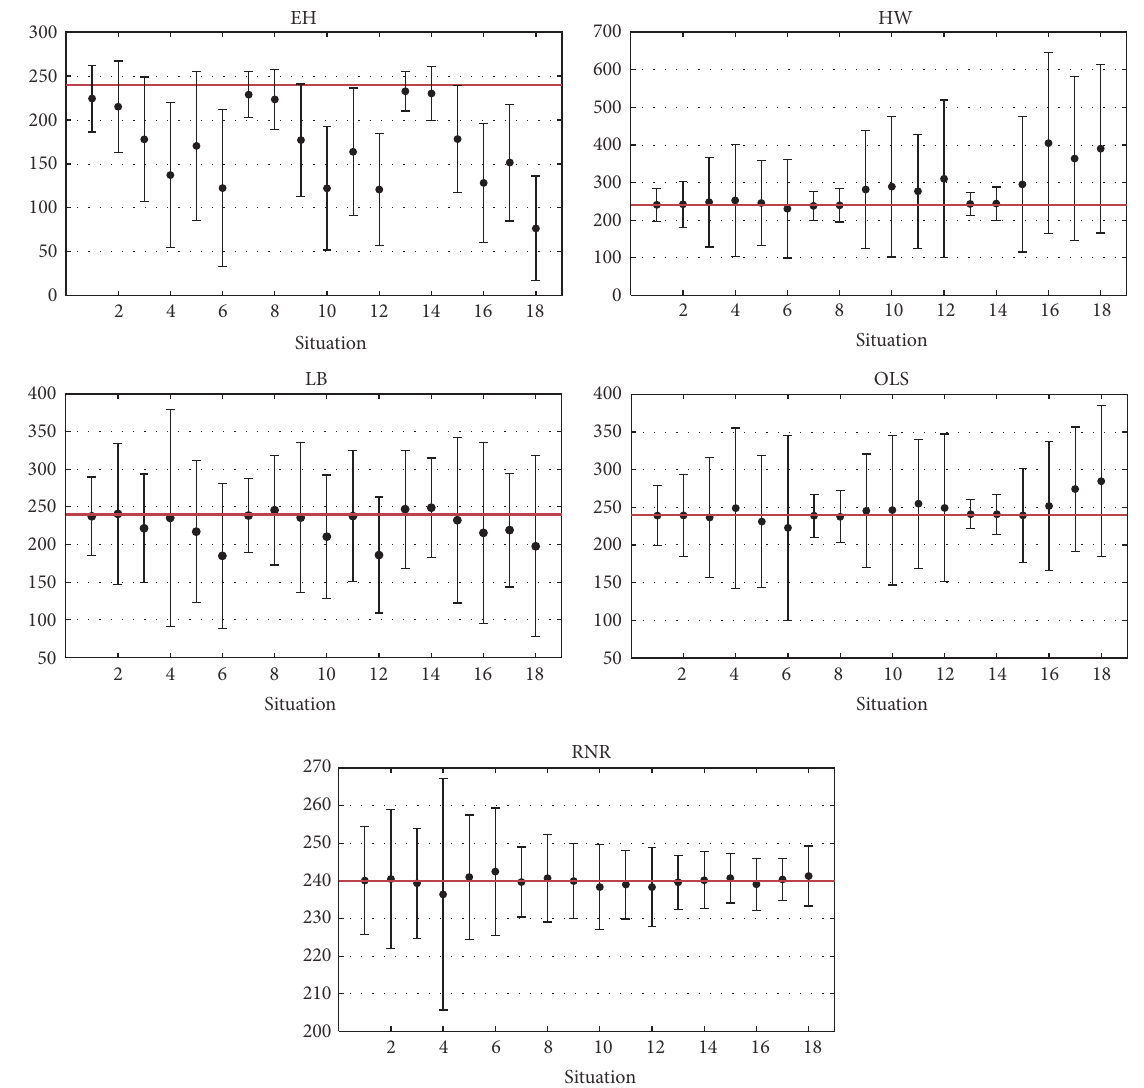
Figure 2: Mean estimated values (black dots) and standard deviations of Michaelis constant, 𝐾 𝑚 , for different simulated scenarios. Red lines denote true parameter